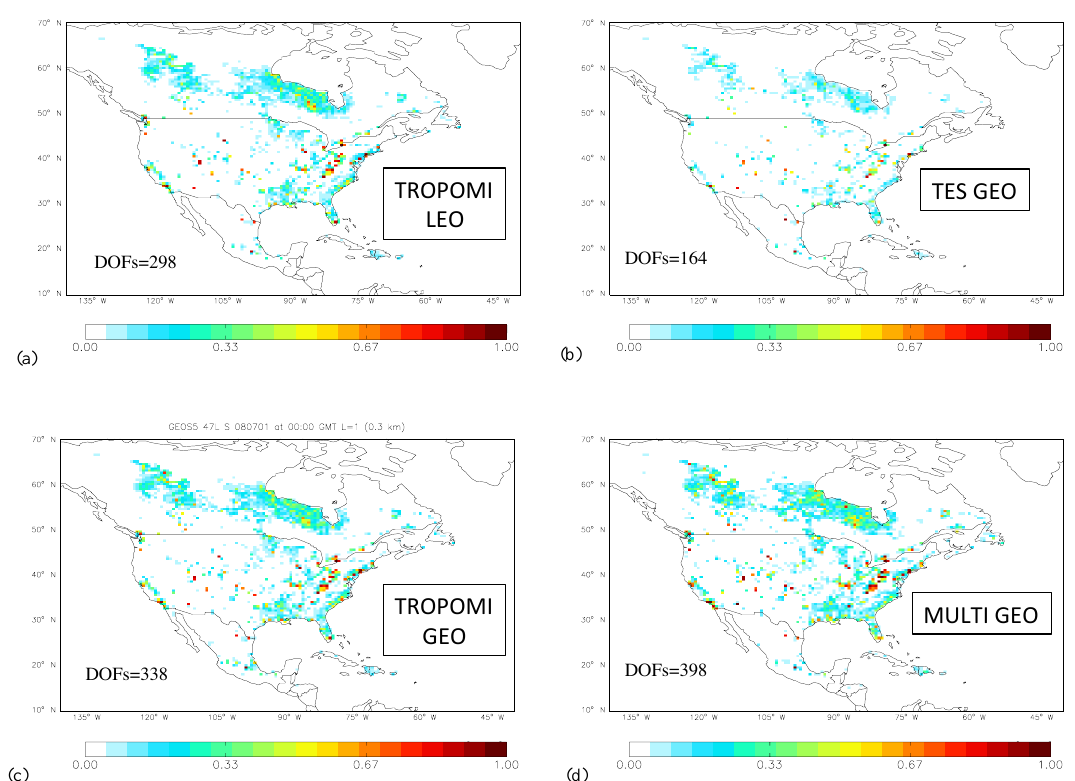
Figure 4. Relative error variance reduction for a 30-day methane emission optimization (1–30 July 2008) using (a) TROPOMI low-Earth orbit observations (TROPOMI_LEO); (b) GEO-CAPE observations with a TES-like instrument (TES_GEO); (c) GEO-CAPE observations with a TROPOMI-like instrument (TROPOMI_GEO); and (d) GEO-CAPE observations with a multi-spectral instrument (MULTI_GEO). Zero values correspond to emissions with no constraints from observations, while values of one correspond to emissions entirely constrained by observations. The DOF for each inversion, which is the sum of all diagonal elements of the model resolution matrix, is also